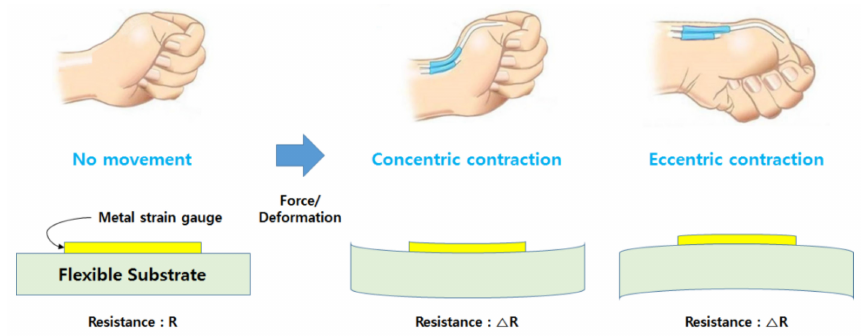
Figure 3. Change of a strain gauge and resistance caused by the movement of a wrist.